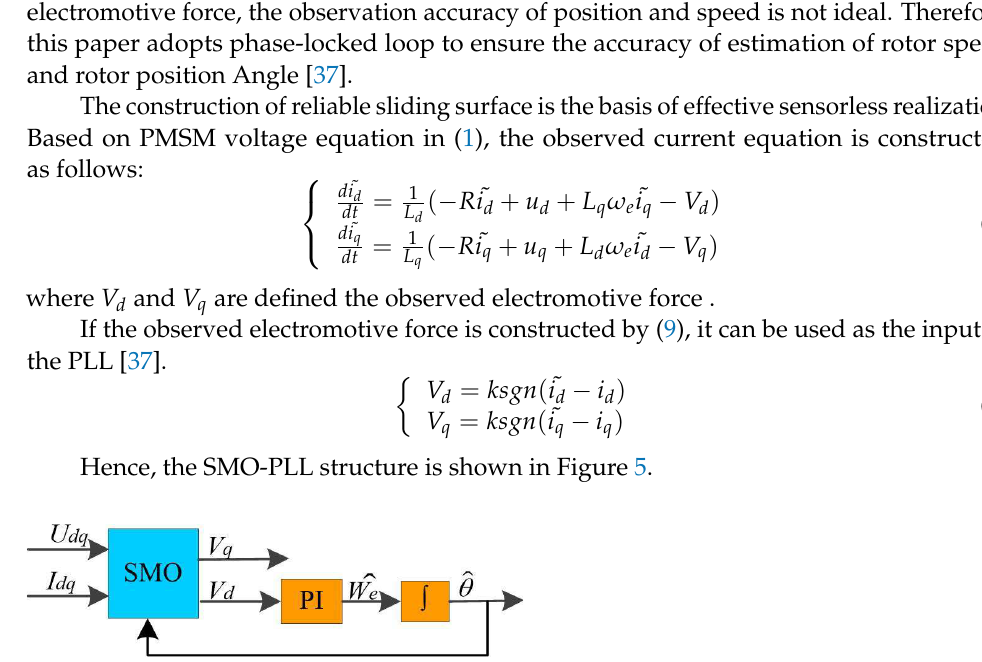
Figure 5. The structural diagram of SMO-PLL